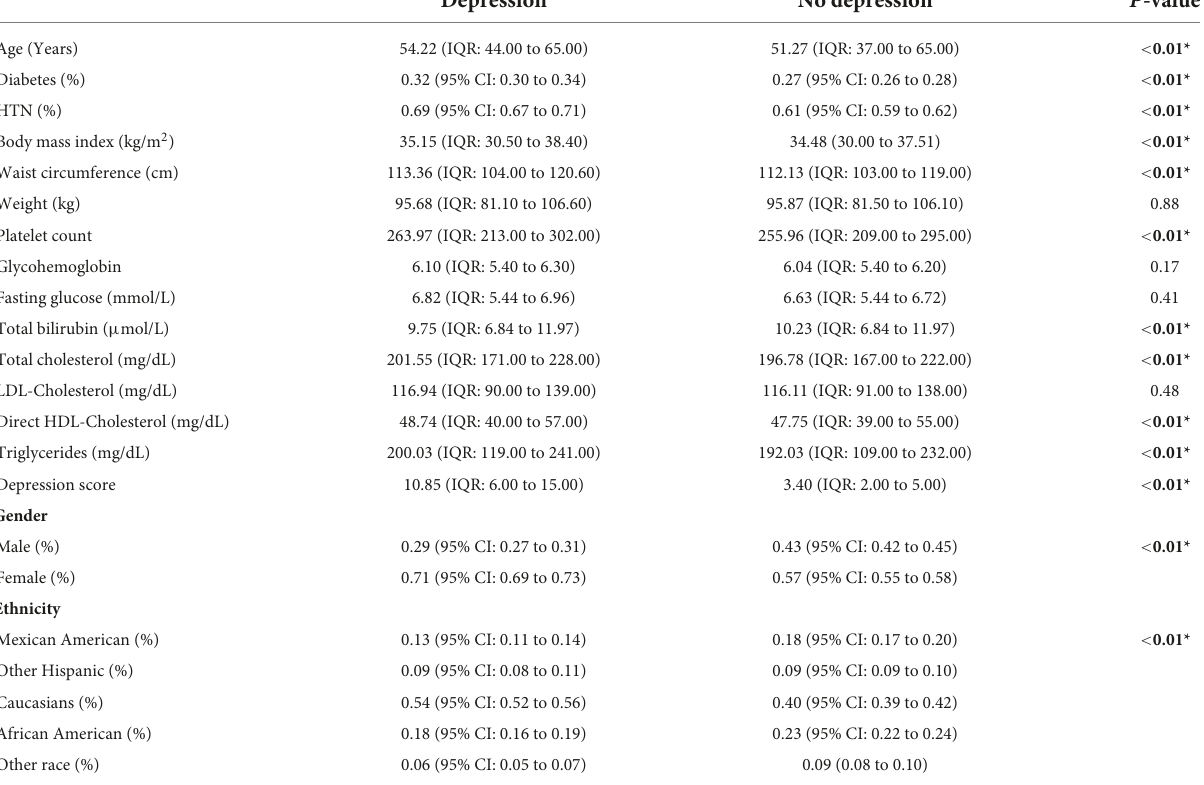
TABLE 2 Baseline characteristics of population with and without depression in